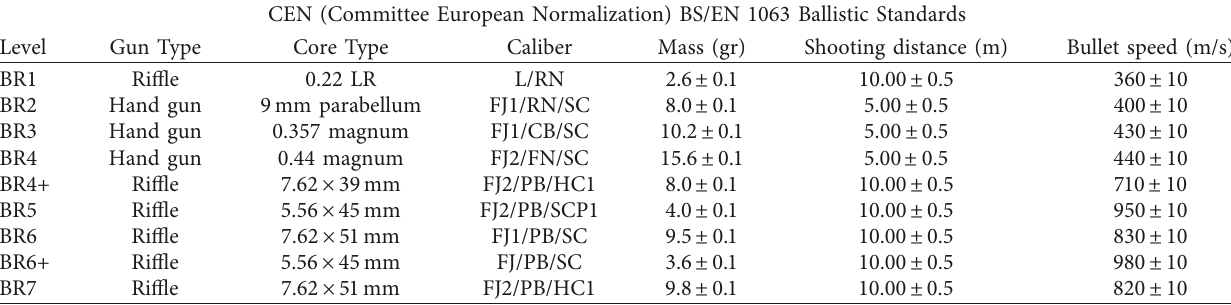
Table 1: Ballistic standards